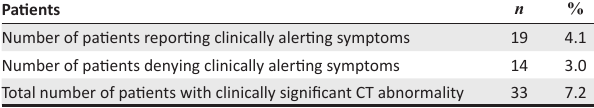
TABLE 2: Number of patients reporting clinically alerting symptoms.